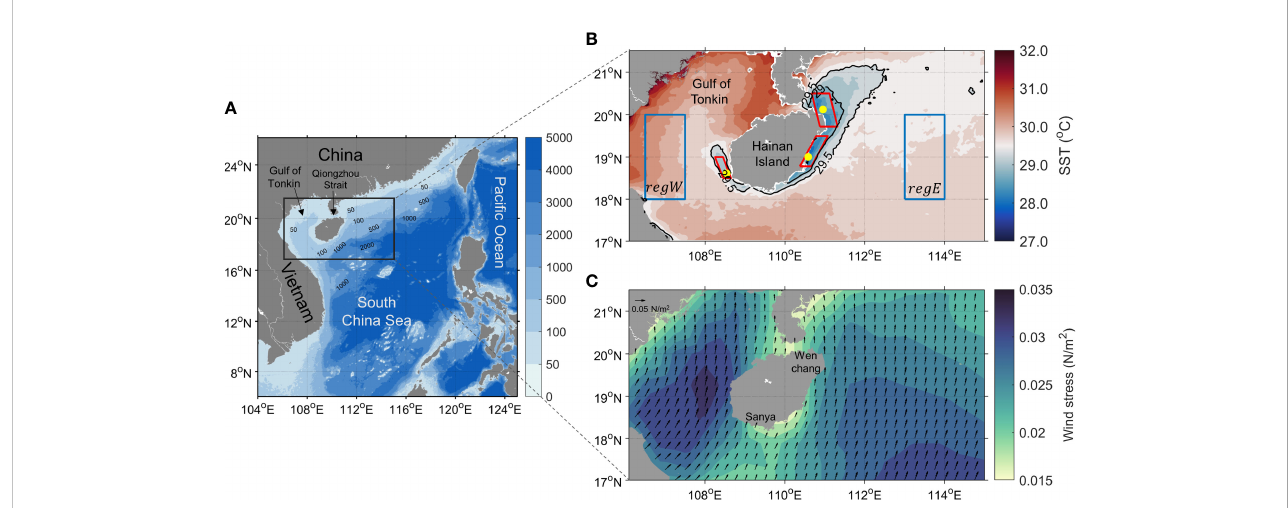
FIGURE 1 Location and topography (m) of study area (A) . The spatial distribution of multi-year (2003-2021) mean summer sea surface temperature (B) and wind stress (C) . Yellow solid circles indicate the locations of the three upwelling cores, the red boxes represent three upwelling regions, and blue rectangles represent the surrounding non-upwelling sea regions in (B) where regE represents 18-20°N, 113-114°E and regW represents 18-20°N,